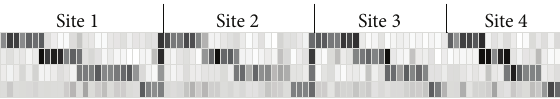
Figure 4: Item memberships of each cluster in full matrices case.